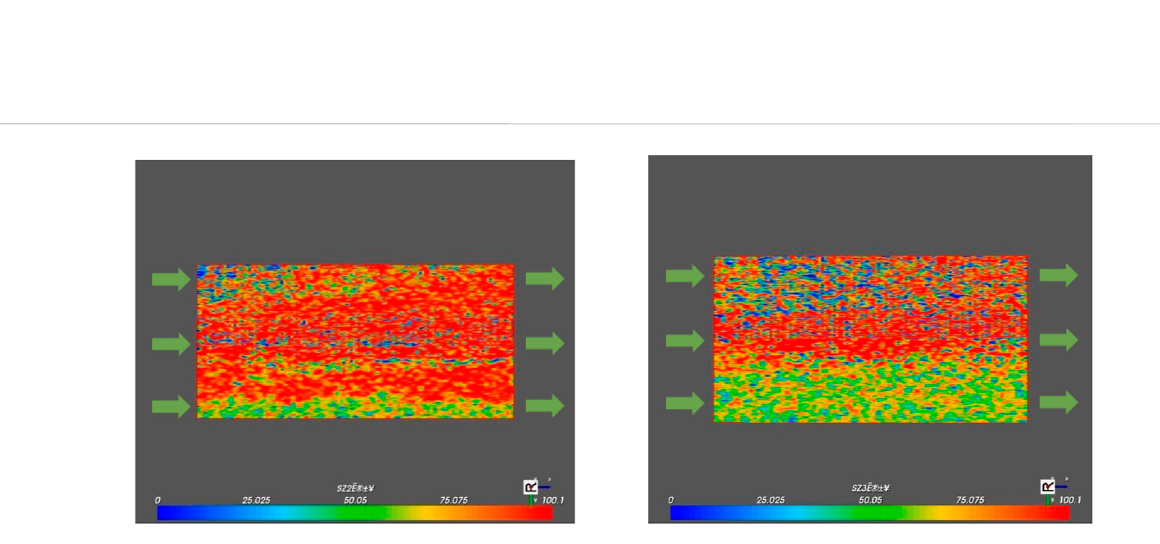
FIGURE 14 Distribution of oil-water saturation in SZ2 (left image) and SZ3 (right image) model respectively.